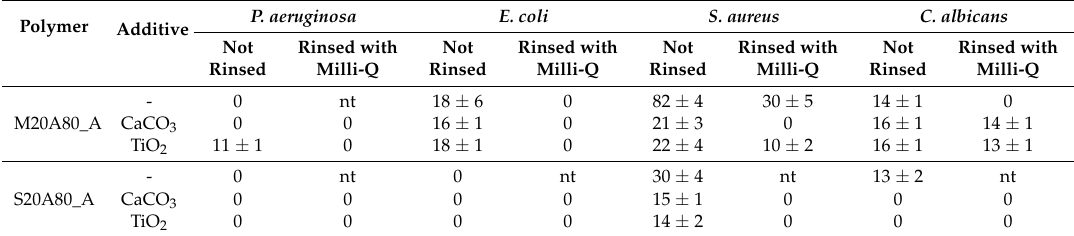
Figure 3. Representative photographs of antimicrobial tests (against E. coli ) in solid culture media. Mueller-Hinton agar (MHA): control plate, MHA + E. coli. : control plate inoculated with E. coli . The black lines indicate the diameters of the zone of growth inhibition. Table 3. Bacterial and yeast susceptibility tests in solid culture media. The latexes were spotted on the bottom of empty Petri dish and left to dry, and subsequently covered by solid cultures of microorganisms. The mean ( ± SD, n = 3) diameters of the zones of growth inhibition are expressed in (mm); nt: not tested.